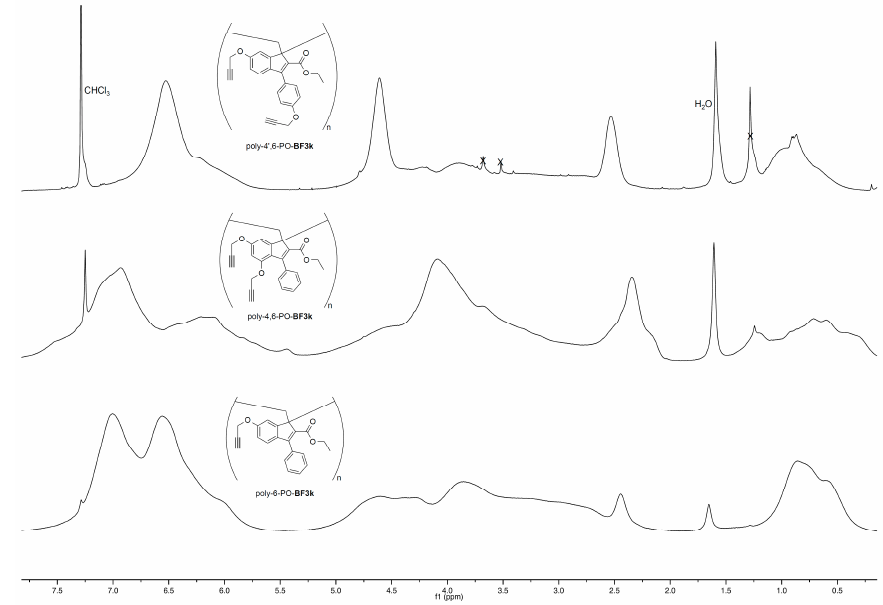
Figure 5. 1 H NMR spectra (600 MHz, CDCl 3 ) of poly-4’,6-PO- BF3k ( top trace ) and poly-4,6-PO- BF3k ( middle trace ) compared with that of previously reported poly-6-PO- BF3k ( bottom trace ). These differences were reflected also in the 13 C NMR spectra shown in Figure 6.